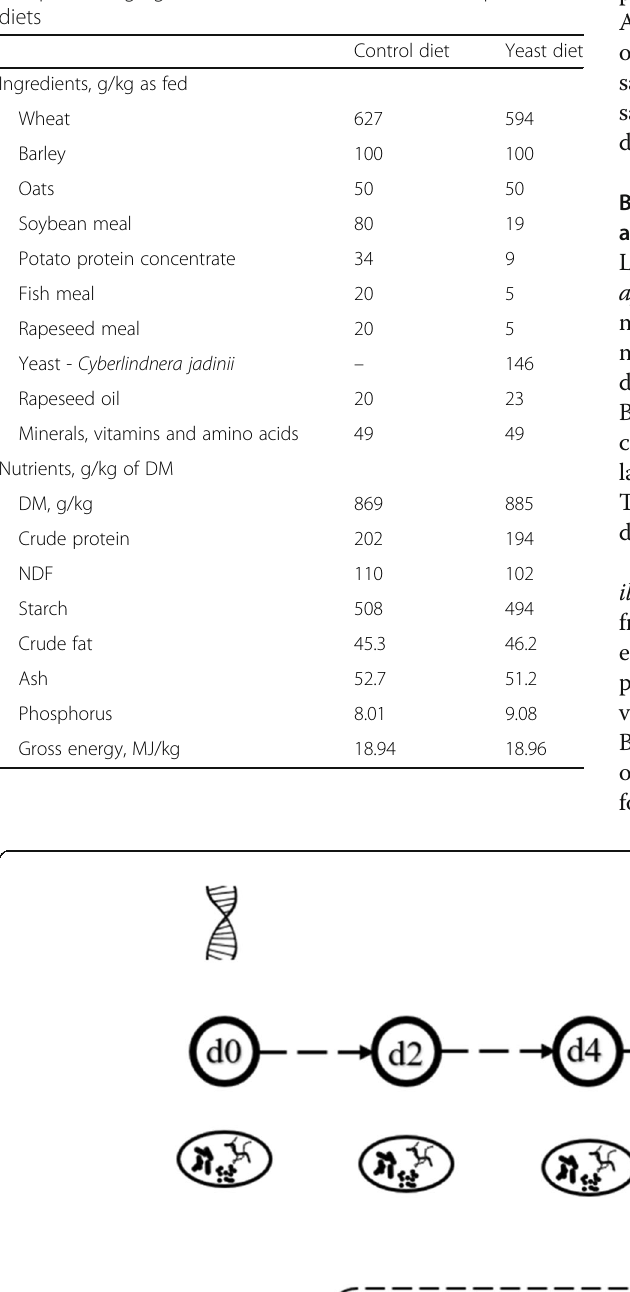
Table 1 Ingredients (g/kg as fed) and analysed chemical composition (g/kg DM, unless otherwise stated) of experimental